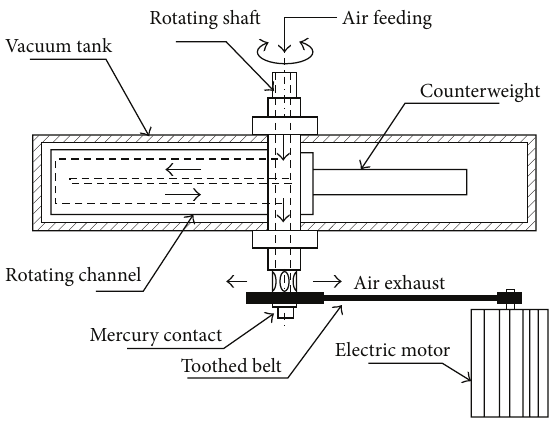
Figure 12: Secondary flows in a rotating channel with radially outward flow; adapted from Gallo et al. [16].